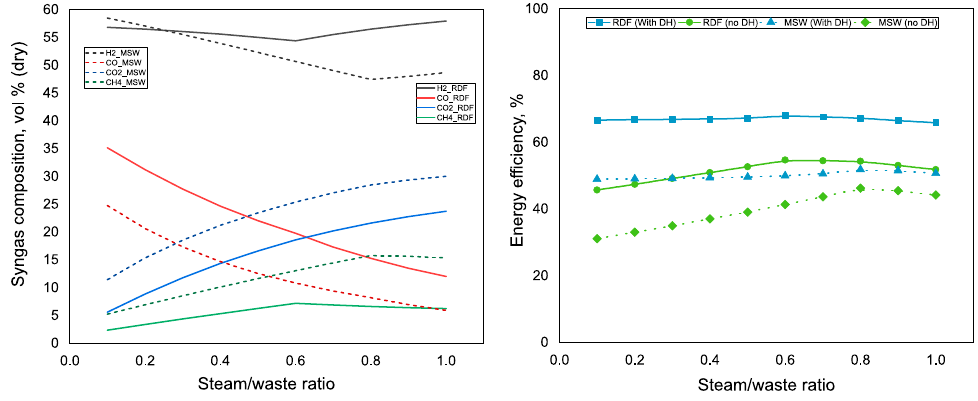
Figure 13. Effect of the steam-to-waste ratio on syngas composition and biofuel synthesis from the DFBG.